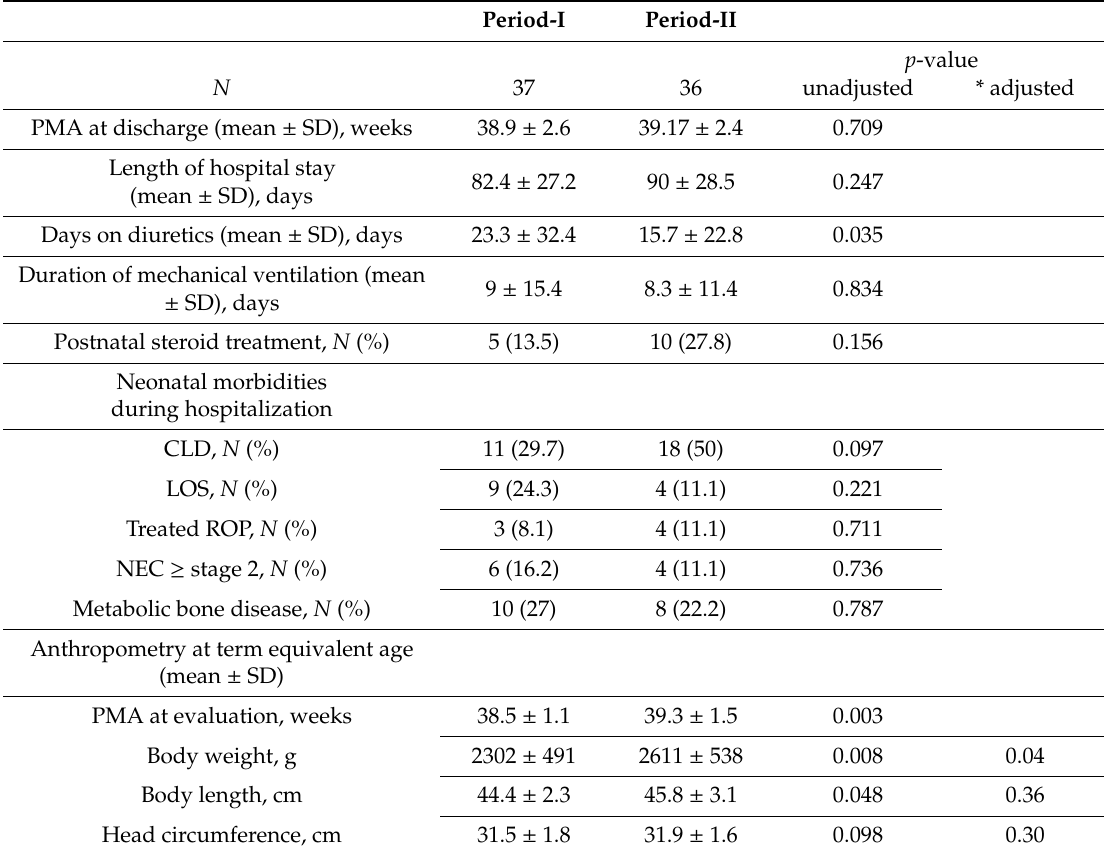
Table 4. Neonatal morbidity, outcome, and anthropometry at discharge and at term equivalent age. Period-I Period-II p -value N 37 36 unadjusted * adjusted PMA at discharge (mean ± SD), weeks 38.9 ±